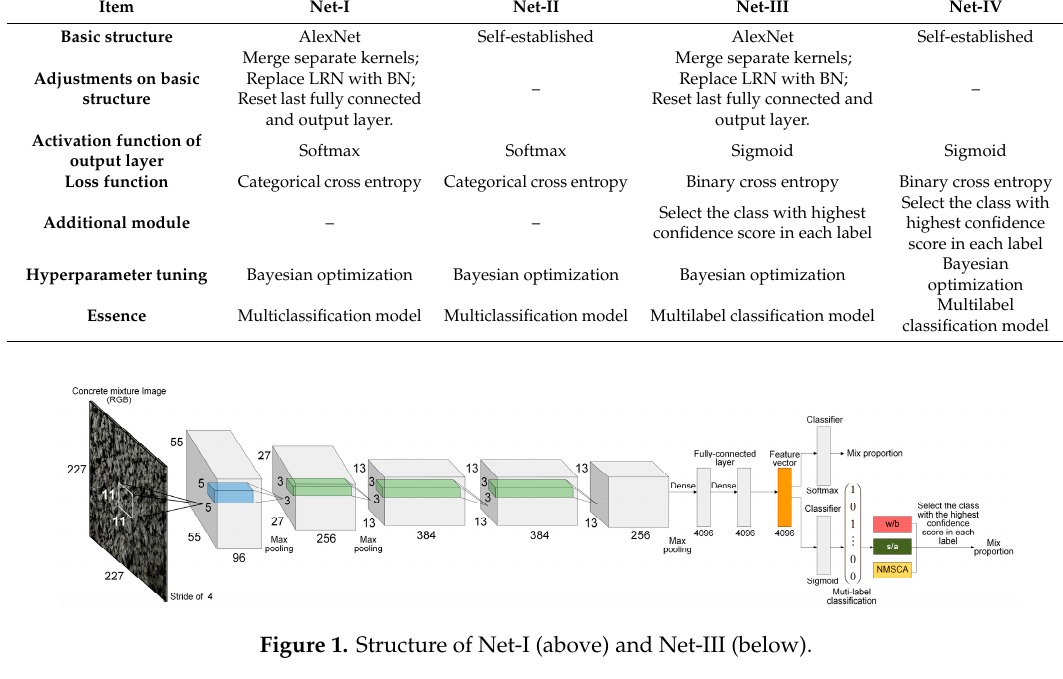
Table 9. Adjustments or improvements of four CNN models.